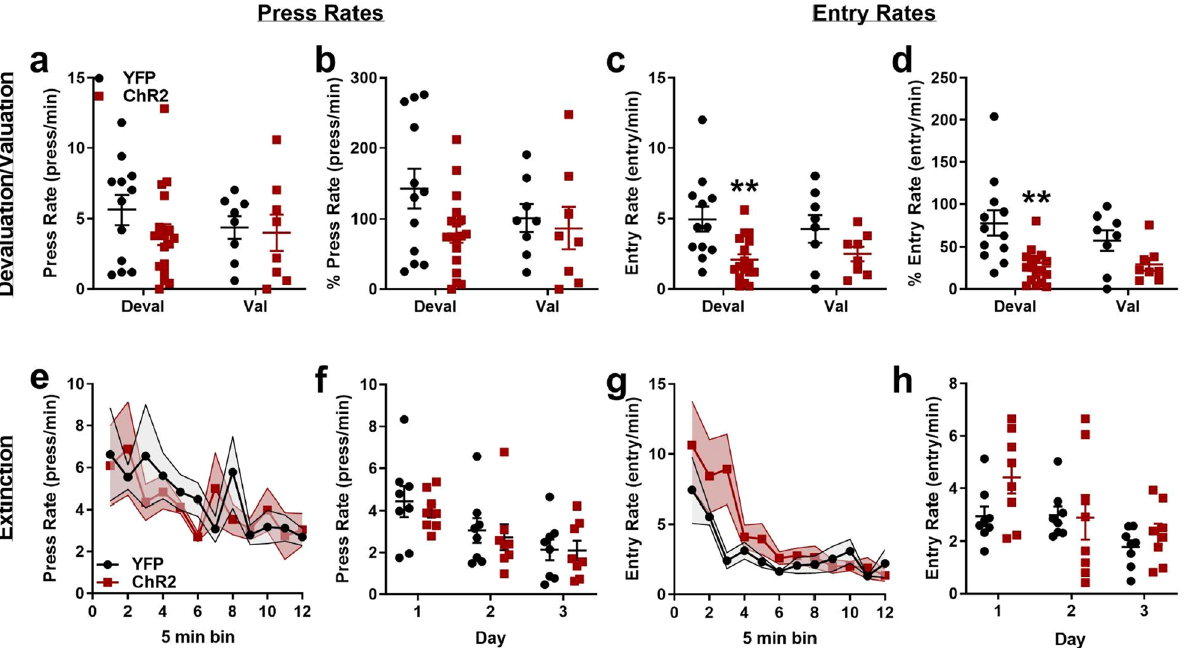
Figure 3. Effects of optogenetic patch manipulation in learning following probe trials and extinction. ( a ) Average press rates during devaluation and valuation probes for ChR2 and YFP mice. ( b ) Press rates normalized to average VI60 response rates for both probe conditions. ( c ) Average entry rates during devaluation and valuation probe trials. ( d ) Entry rates normalized to average VI60 entry rate for both probe conditions. ( e ) Press rates in 5 min bins across the first day of extinction. ( f ) Average press rates across three days of extinction ( g ) Head entry rates in 5 min bins across 60 min extinction trials ( h ). Entry rates and across three days of extinction. * p < 0.05; ** p < 0.01; error bars,